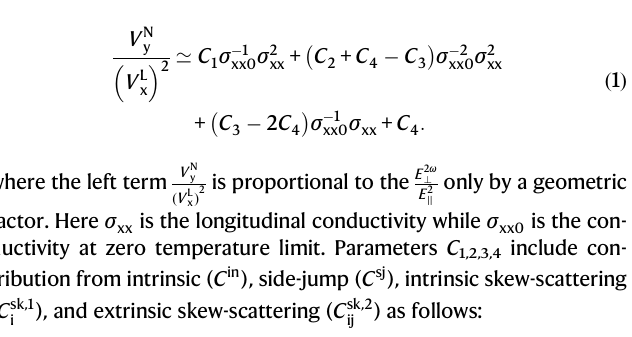
Fig. 5 | Temperature dependence of the 2 nd harmonic Hall effect. a , b E 2 ω ? of bilayer MoTe 2 as a function of temper a tures ( a ) and conductivity ( b ). c , d E 2 ω ? of trilayer MoTe 2 as function of temperature ( c ) and square of conductivity ( d ). Blue linesin a and c areguidestotheeye.Redcurvesin b and d areparabolicand linear fi tstoexperimentaldataforabilayerandtrilayersample,respectively.Symbolsfor